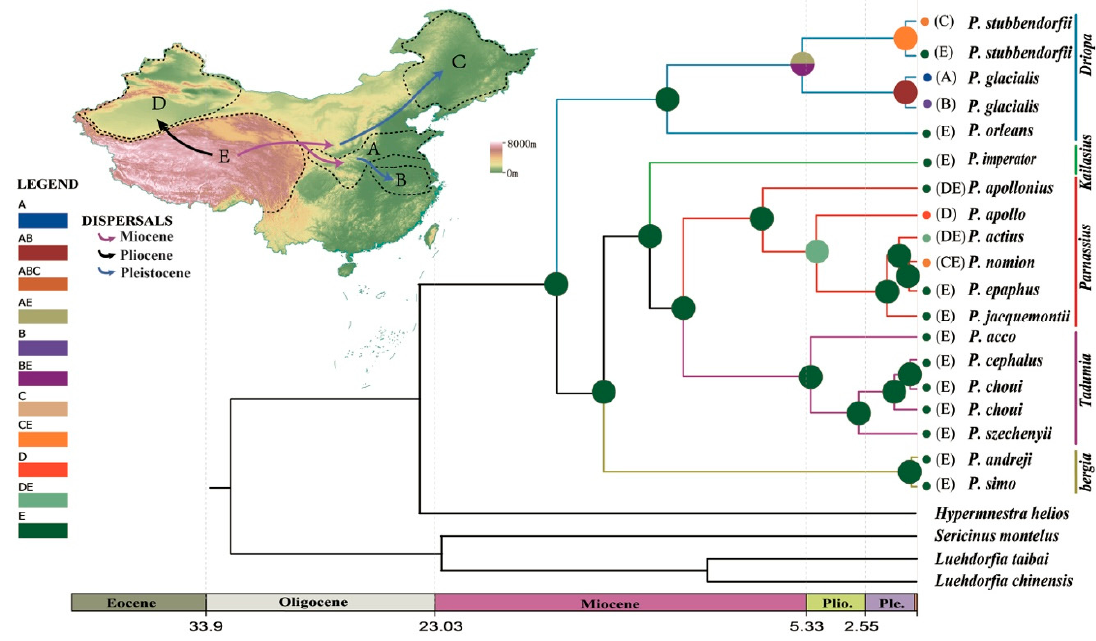
Figure 8. Chronogram and ancestral area reconstruction of Parnassius in China based on mtDNA. Ancestral area assignments at nodes represent marginal probabilities of alternative ancestral distributions obtained by statistical dispersal-vicariance analysis (S-DIVA). ( A ) Qinling Mountains-Huaihe River region; ( B ) area south of the Huaihe River; ( C ) northeast China; ( D ) Xinjiang; and ( E ) the Qinghai-Tibet Plateau (QTP). Data from C and D were not included in this